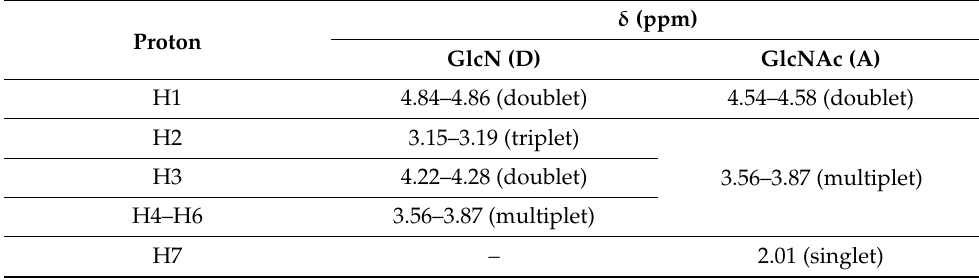
Table 1. 1 H-NMR chemical shifts of chitosan